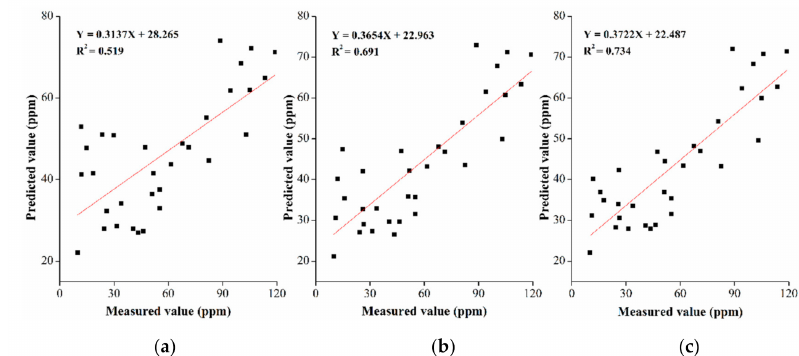
Figure 12. Scatter plots of observed Cu content and predicted Cu content for di ff erent band selection algorithms, ( a ) genetic algorithm (GA), ( b ) continuous protection algorithm (SPA), and ( c ) competitive weighting resampling algorithm (CARS).